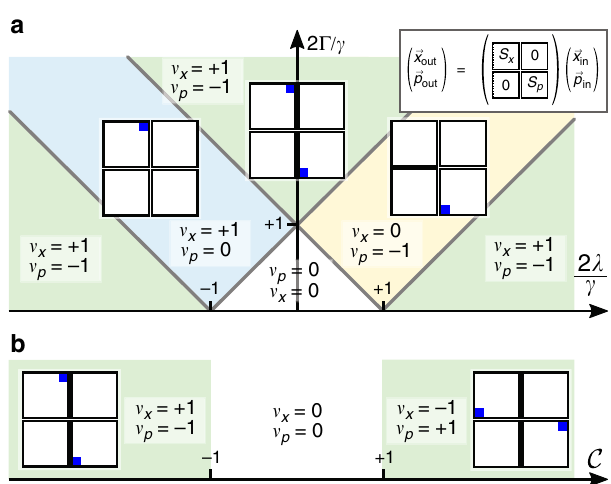
Fig. 6 Topological ‘ phase diagram ’ for the phase sensitive ampli fi er, Eqs. (34) and (35), and the bosonic Kitaev chain, Eq. (38). Topological regimes for ( a ) the phase sensitive ampli fi er of Fig. 5c, and (b) the bosonic Kitaev chain of Fig. 5 (d). We sketch the scattering matrix ∣ S (0) ∣ 2 , whereby the blue rectangles indicate the dominant matrix elements. It is block diagonal for both systems (see inset), since their equations of motion decouple, with blocks S x and S p addressing x and p quadratures, respectively. Each block is obtained from Eq. (23). In a depending on the parameters Γ and λ , either the x quadratures are in a non-trivial regime, the p quadratures, both or none. The central white region is topologically trivial, so the gain is Oð 1 Þ . In b , either both x and p quadratures are in a non-trivial regime with ν x = − ν p , or ν x = ν p = 0. Since the winding numbers ν x and ν p have opposite sign, the ampli fi cation direction is the reverse for the two